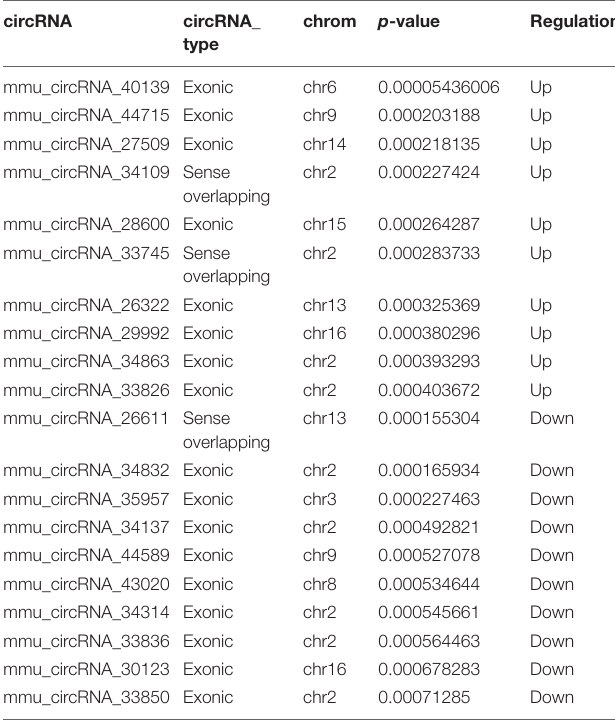
TABLE 2 | Top 10 up- and down-regulated DEcircRNAs in the hippocampus of Nrf2 ( − / − ) mice.